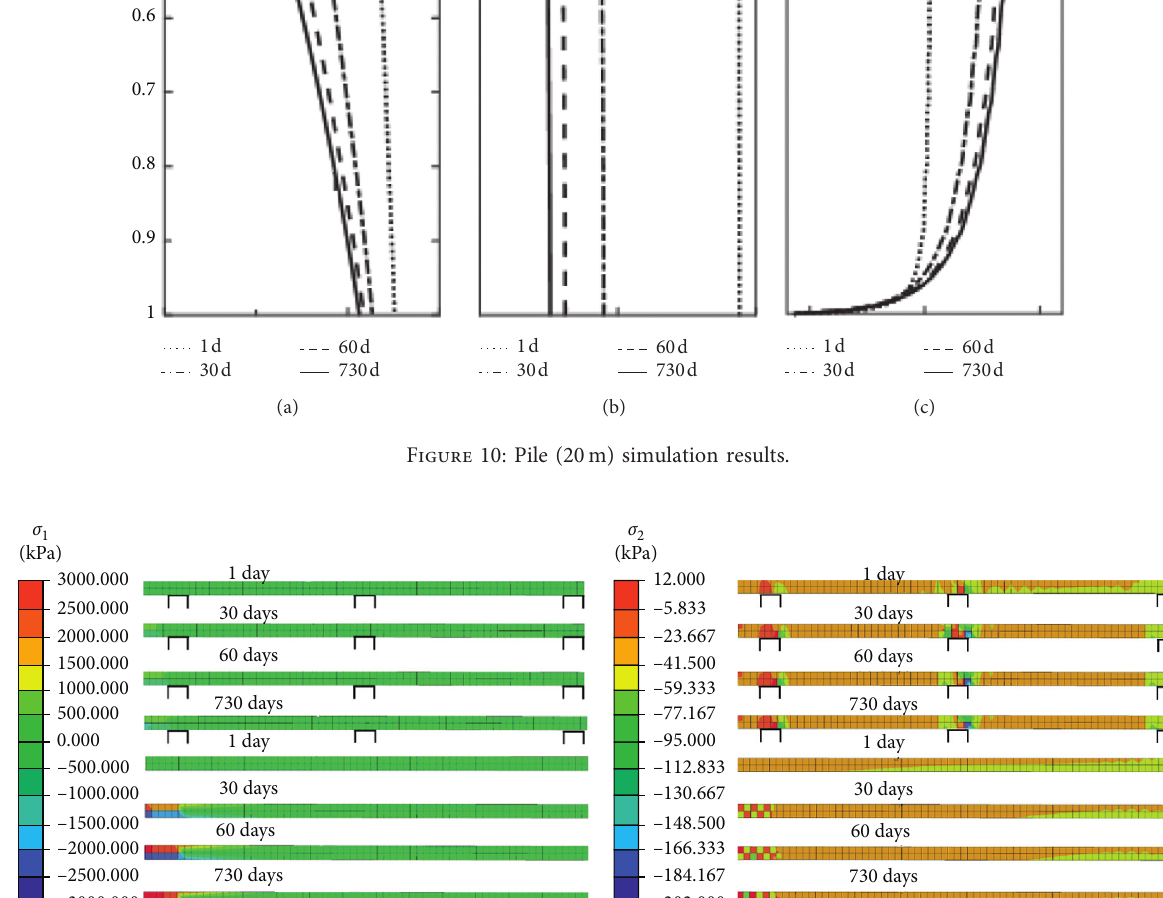
Figure 11: Comparison of the force of the lower partition slab-pile foundation and deep-seated concrete